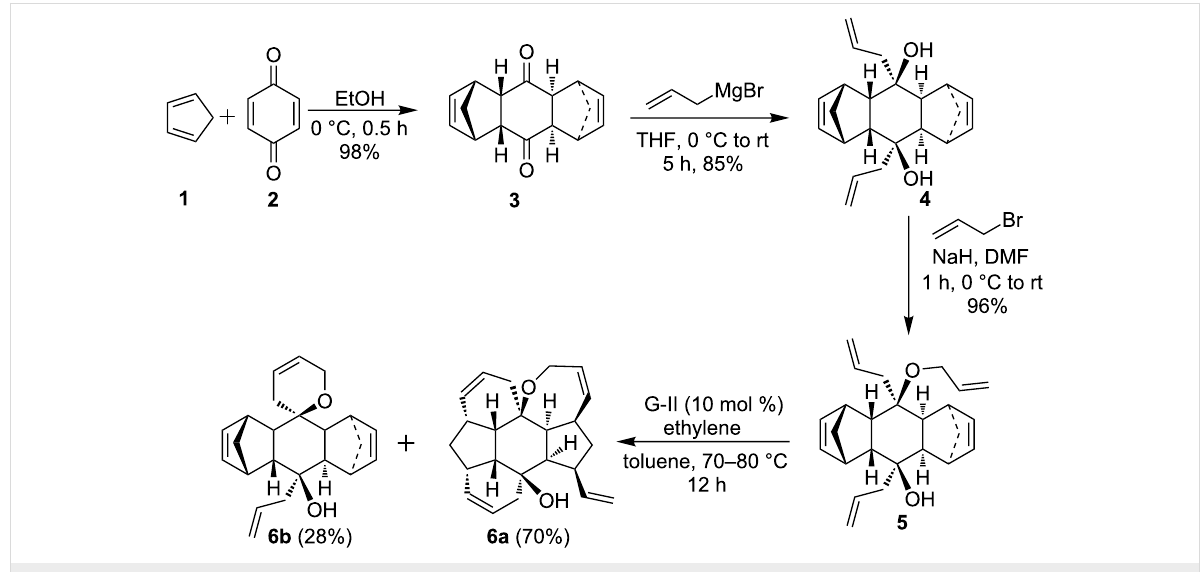
Scheme 1: Synthesis of hexacyclic compound 6a by using an RRM approach.